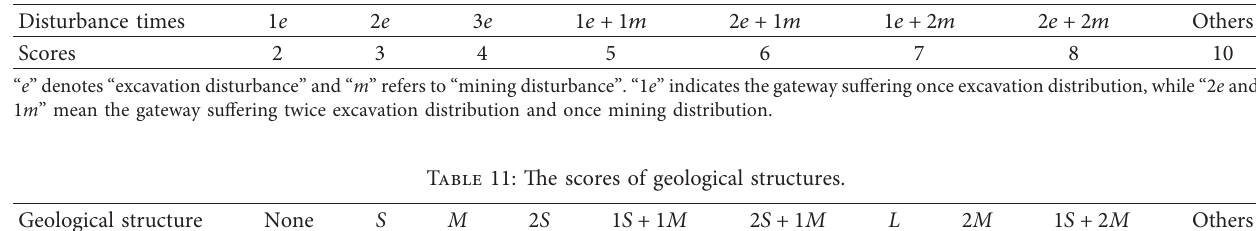
Table 10: The scores of disturbance times from mining.